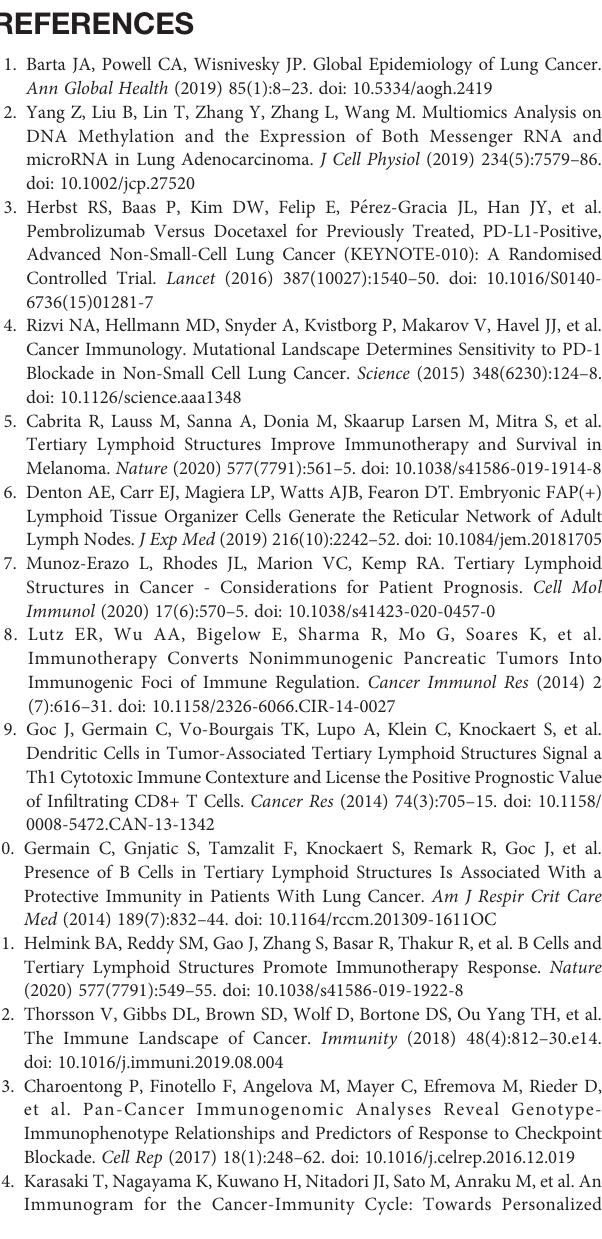
Supplementary Figure 6 | Differences in OS and PFI between the TLS signature high and low groups with positive or negative EGFR-TKI-sensitive mutations. (A) Kaplan – Meier plots of overall survival difference between tumors with TLS high and low groups in LUAD with positive (high group n=29, low group n=14) or negative EGFR-TKI-sensitive mutations (high group n=13, low group n=8); (B) Kaplan – Meier plots of progression free survival difference between tumors with TLS high and low groups in LUAD with positive (high group n=29, low group n=14) or negative EGFR-TKI-sensitive mutations (high group n=13, low Supplementary Table 1 | Basic clinical information of LUAD patients in the TCGA cohort. Supplementary Table 2 | Basic clinical information of LUAD patients in the GSE37745